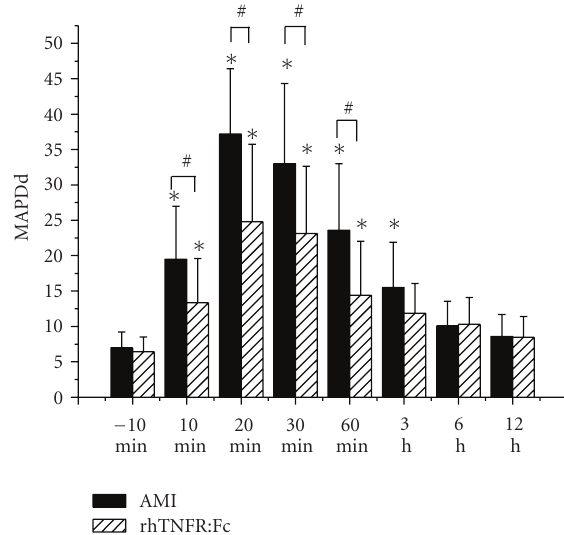
Figure 6: The variation of the MAPDds in the border zones. Compared to that before ligation, MAPDds in the border zone of the two groups after ligation significantly increased, ∗ P < . 01; MAPDds in the border zone of rhTNFR:Fc group were significantly less than AMI group, # P < . 05.